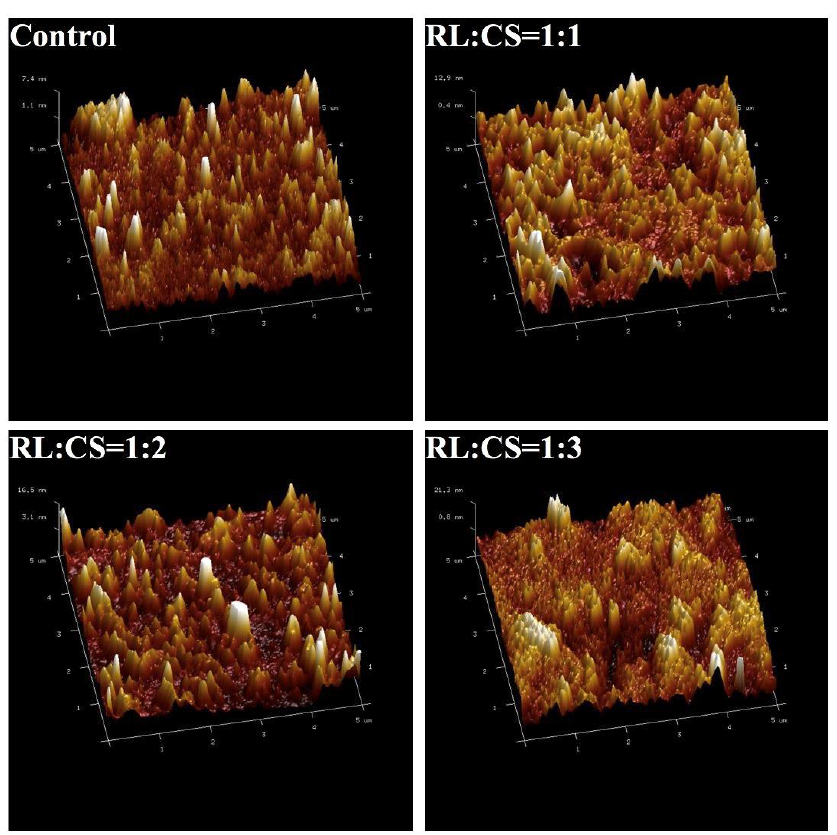
Figure 2. Atomic force microscopy image of Cur-RL-Lips (Control) and CS-coated Cur-RL-Lips with different ratios of RL/CS (RL:CS = 1:1, 1:2, and 1:3).